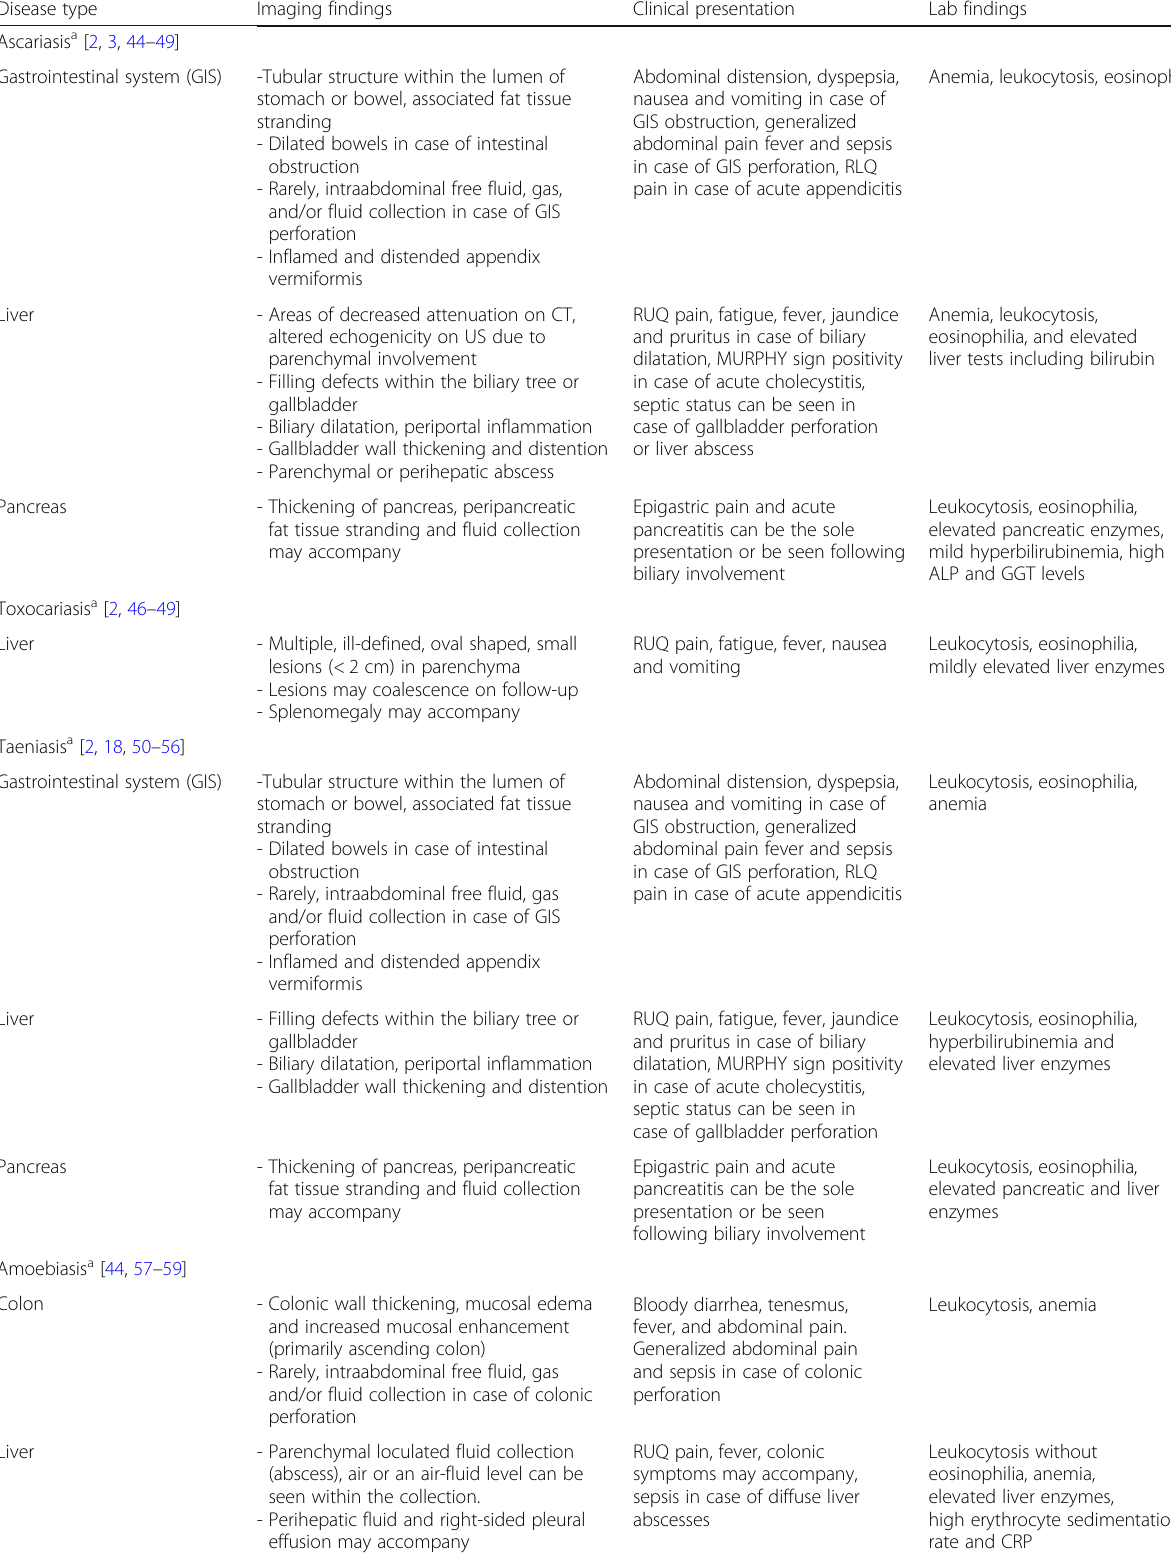
Table 2 Parasitosis and affected abdominal organs. Associated radiological, clinical, and laboratory findings (Continued) Disease